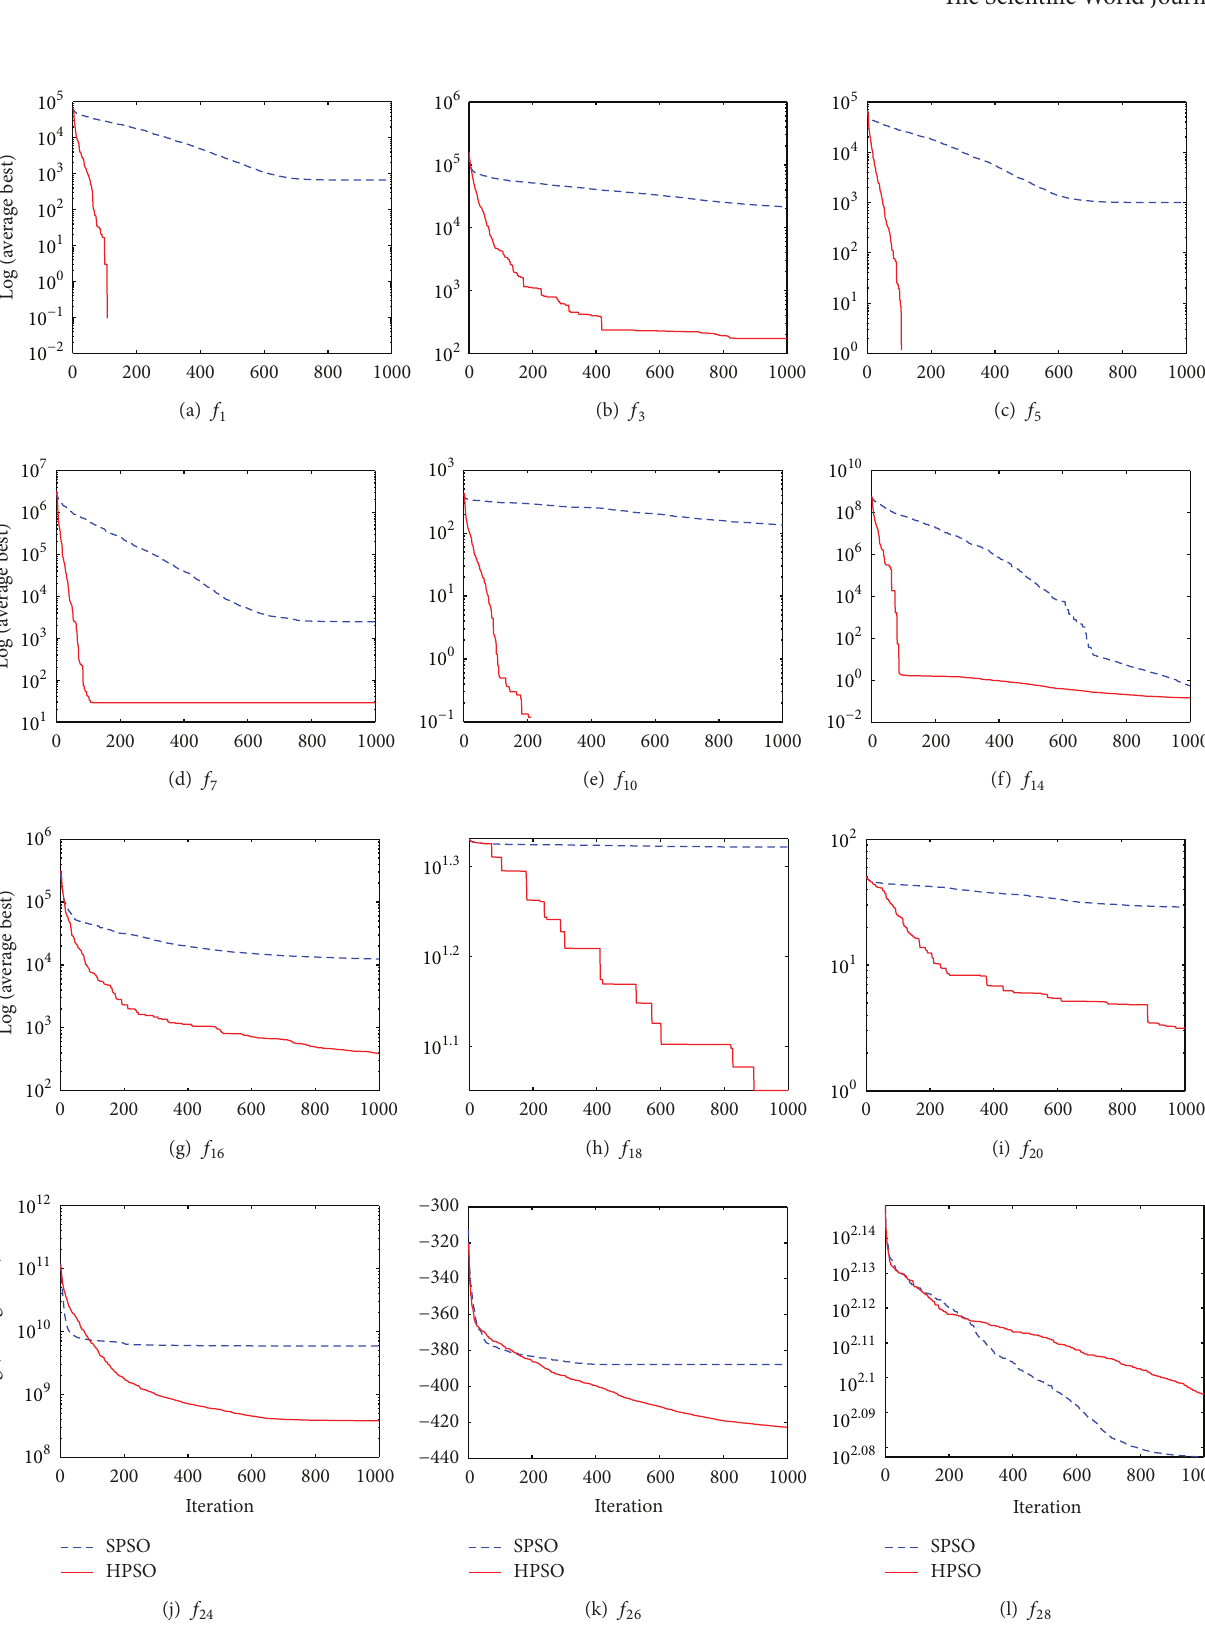
Figure 4: Convergence comparison of HPSO and SPSO on the selected test functions with 𝐷 = 30, 𝑁 = 30 , and 𝑇 = 1000